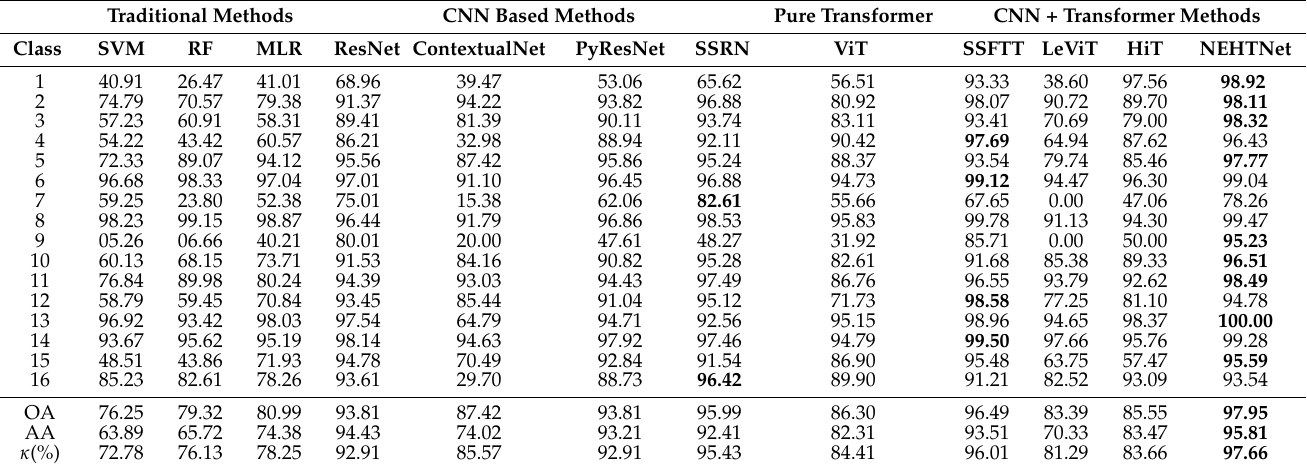
Table 8. Classification Accuracy of Different Methods for Labeled Pixels of The IP Data